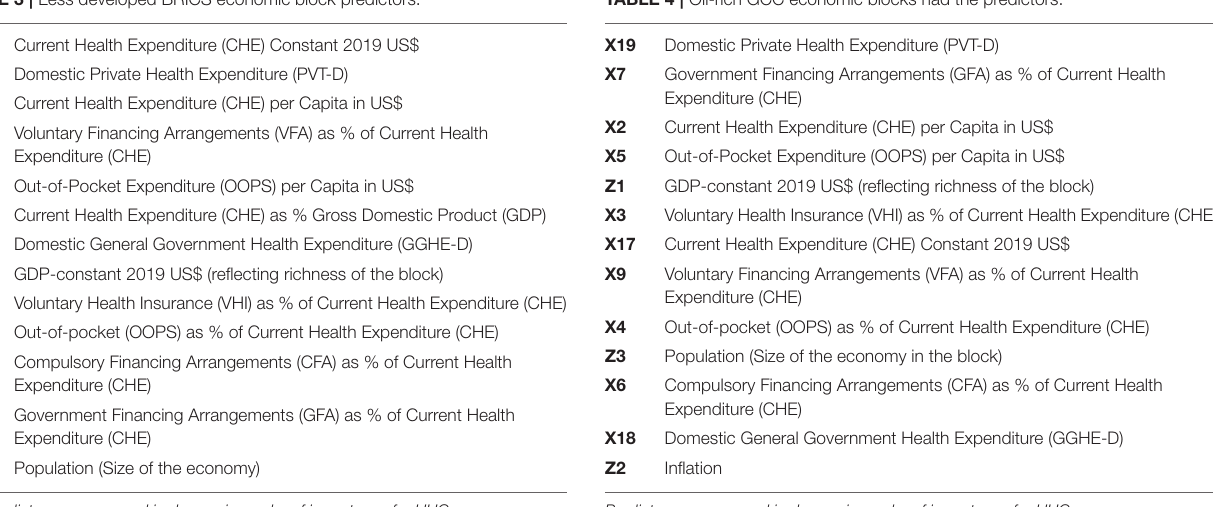
TABLE 3 | Less developed BRICS economic block predictors. TABLE 4 | Oil-rich GCC economic blocks had the predictors.